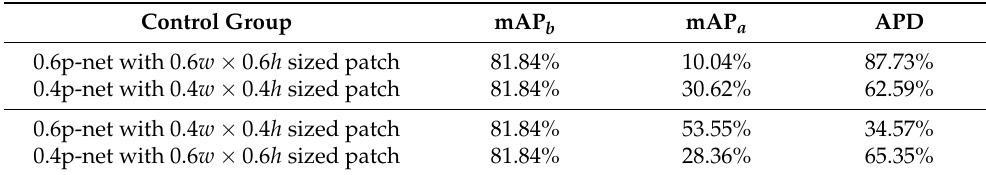
Table 3. Comparison of the different-sized